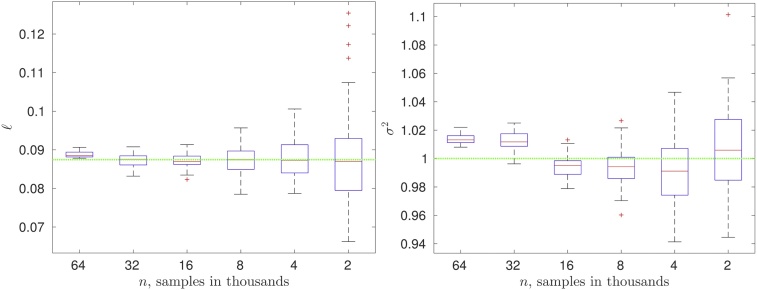
Synthetic data with known parameters (ℓ*,ν*,σ*2)=(0.0864,0.5,1.0). Boxplots for ℓ and σ2 for n = 1, 000 × {64, 32,…, 4, 2}; 100 replicates.